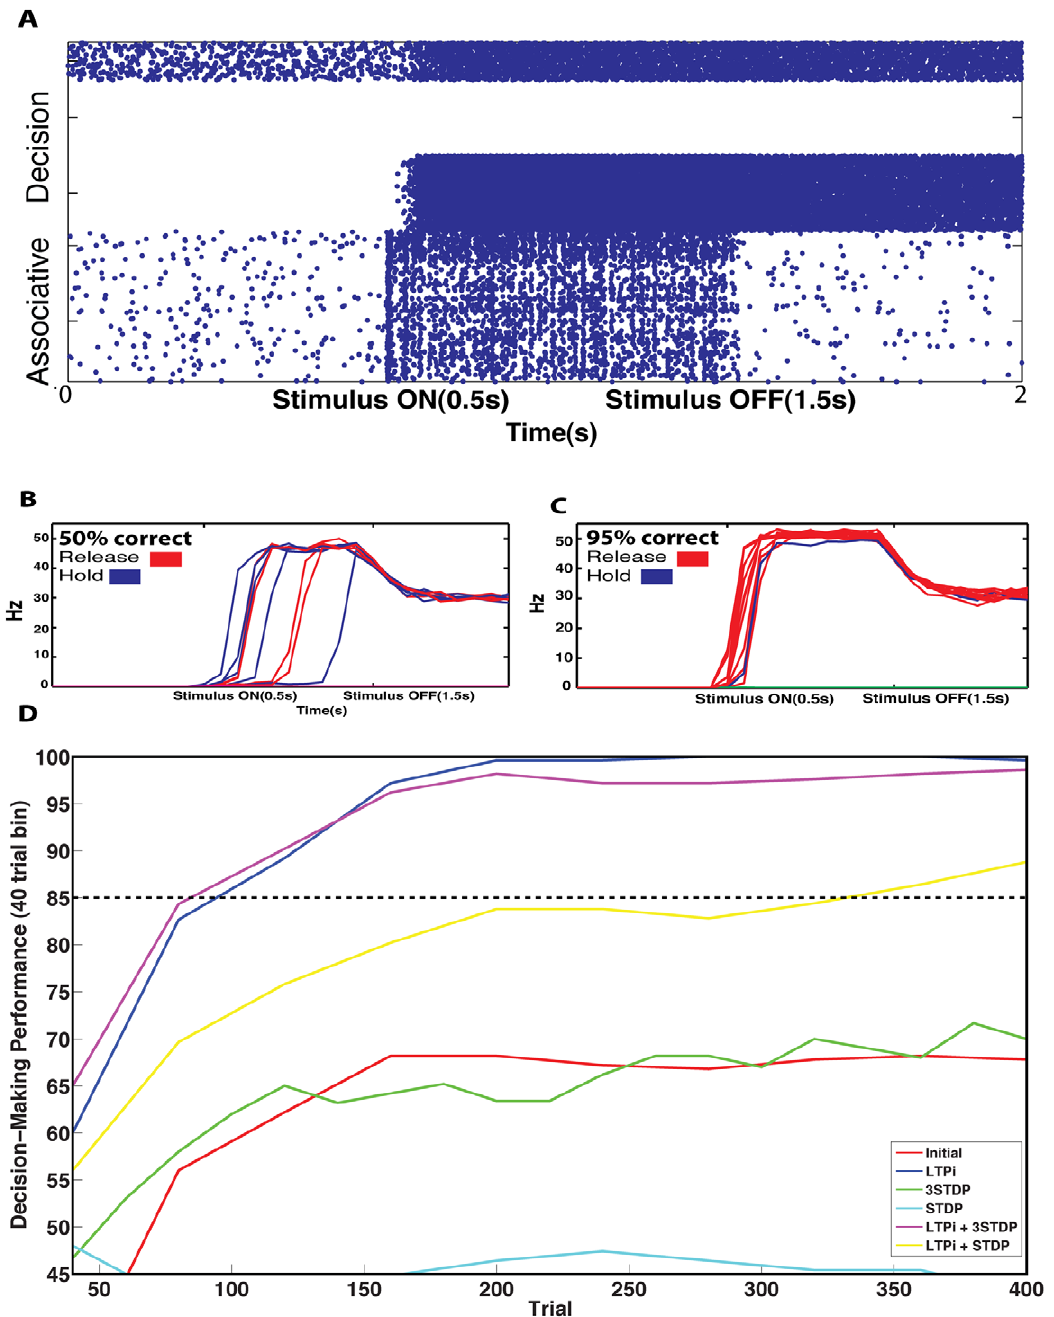
Figure 6. DA modulated reward learning increases decision-making performance. A . Single A + B trial spike raster shows the activity during a ‘‘Release’’ trial where spiking from the Associative layer correctly drives a release response, resulting in DA and thus reward. Before reward-based learning ( B ) the network operates at chance performance. Following reward-based learning in the trained network ( C ) the network generates reliably correct decisions. D . Decision-making performance in 40 trial bins for each plasticity rule and initial conditions. The three networks trained with LTPi (LTPi alone (blue), LTPi with standard (cyan) or triplet STDP (magenta)) all produce reliably correct decisions consistent with their high selectivity. The initial network (red) or networks trained with only triplet (green) or standard (yellow) STDP fail to generate reliable decisions consistent with their lower stimulus-pair selectivity (network 2,1/3).